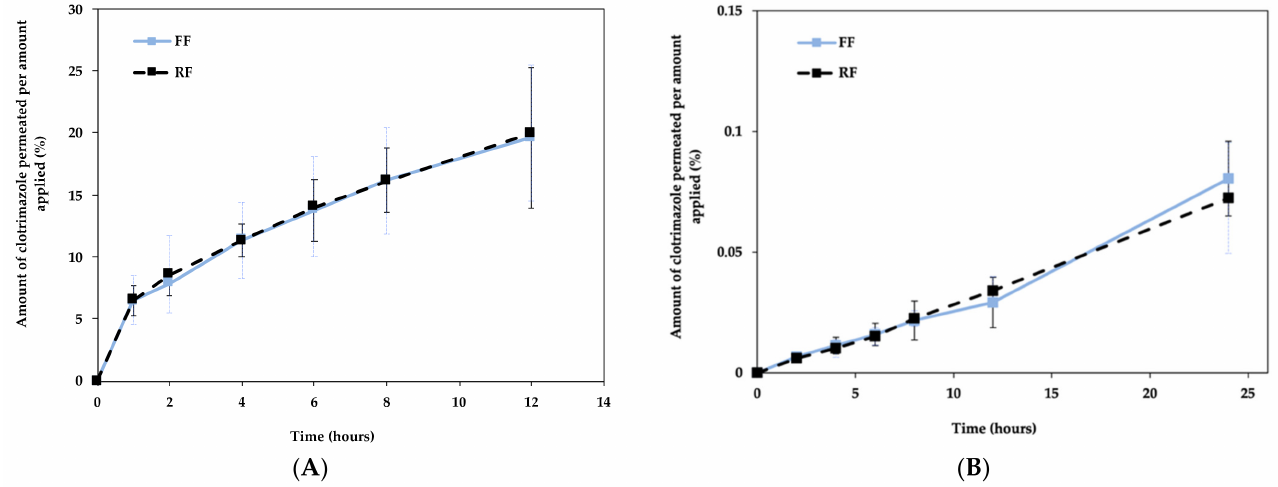
Figure 8. Release profile of drug from the FF and RF through synthetic membranes ( A ) and permeation profile of drug from the FF and RF through newborn pig skin ( B ). Data are mean ± SD, n =